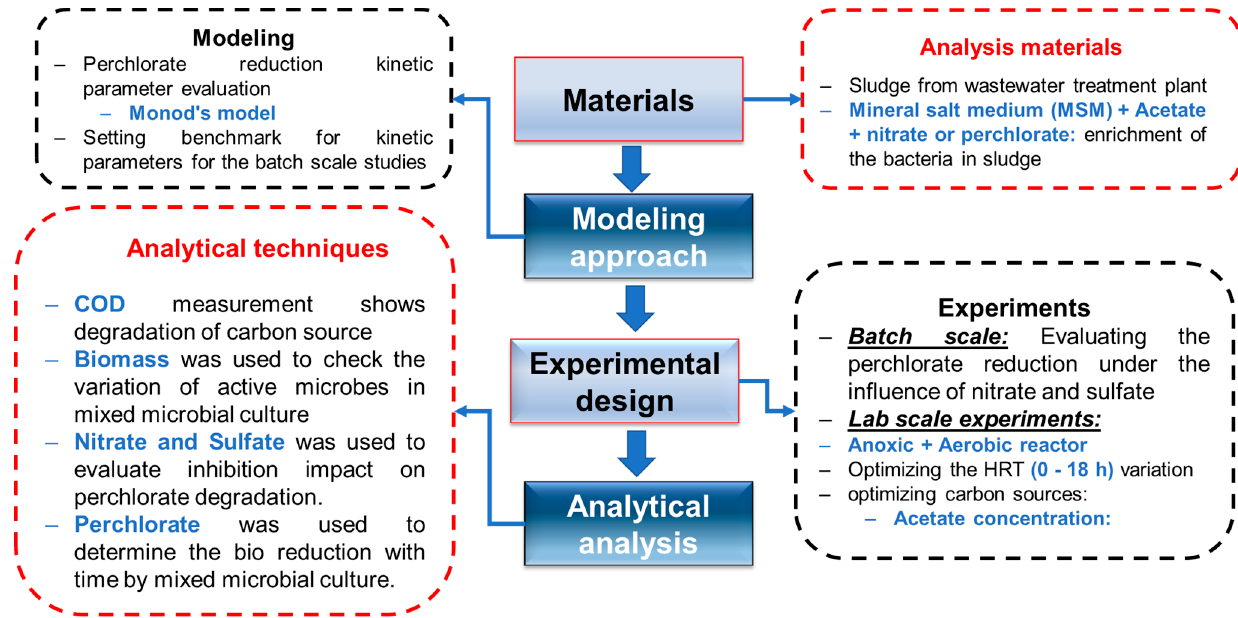
Figure 5. Schematic diagram of the experimental study.